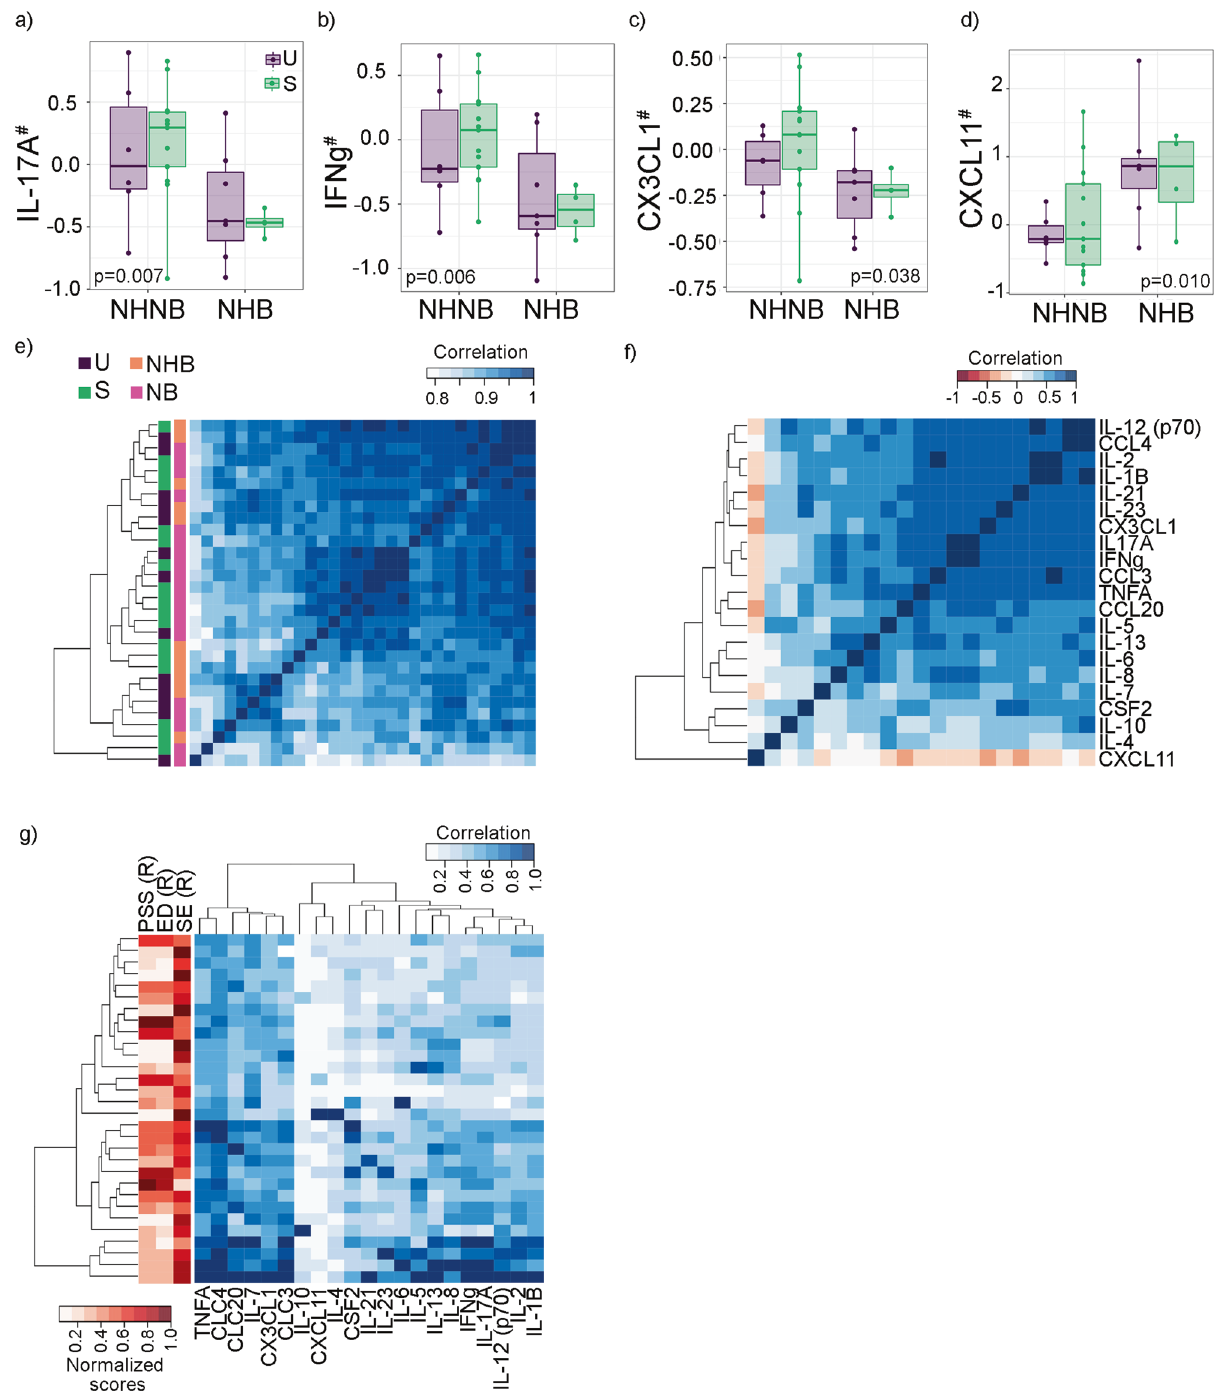
Fig. 3 Immune system, race and rPS scores during the second trimester of gestation. a – d Several cytokines were associated with race and ethnicity — models were corrected by participants ’ BMI; e Associations between cytokines and chemokine levels (log scale) corrected by participants ’ BMI and recruitment site. f Partial Spearman correlation between cytokines and chemokines levels in serum at the second trimester correcting for participants ’ BMI. While most of the cytokines and chemokines positively correlated with each other, only CCXL11 concentrations in serum were negatively correlated with the rest. g Clustering of cytokines and chemokine (log normalized) level by